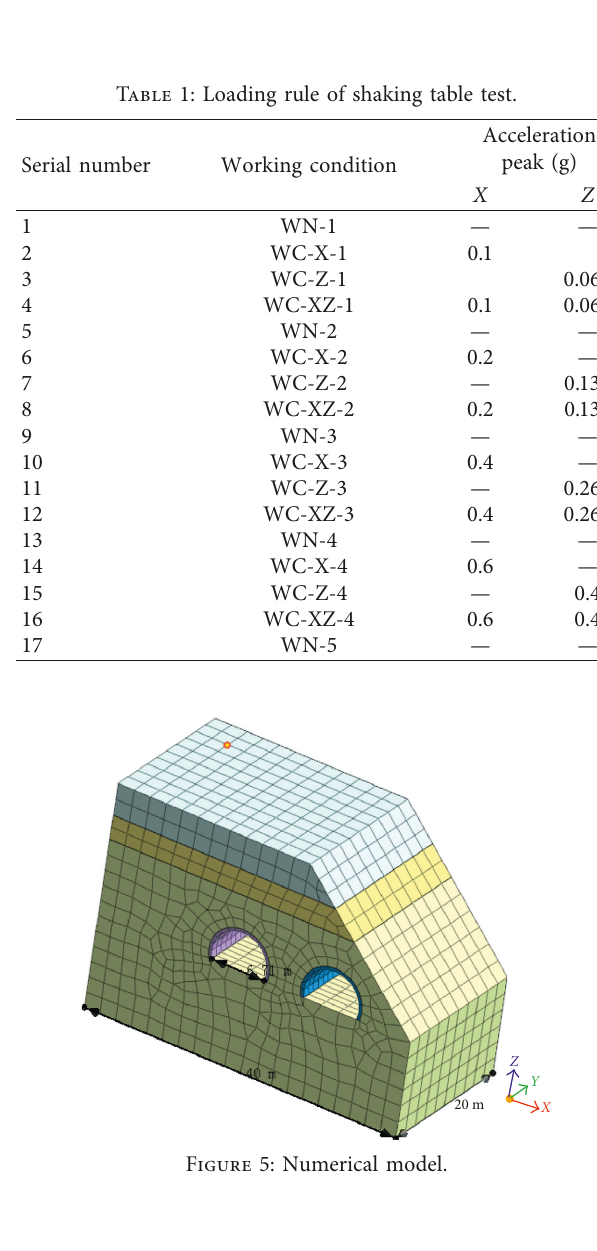
Figure 2: Slope model and locations of transducers.